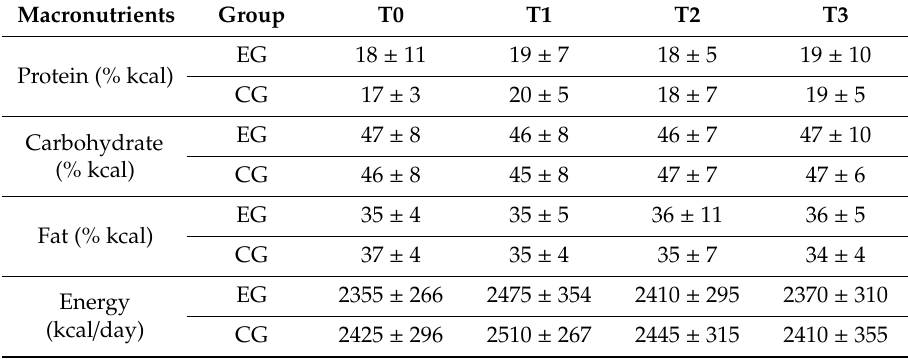
Table 1. Macronutrient values (means ± SD) of the experimental group (EG) and control group (CG) measured 24 h before the start of Ramadan (T0), on the 15th day of Ramadan (T1), the day after the end of Ramadan (T2) and 21 days after the end of Ramadan